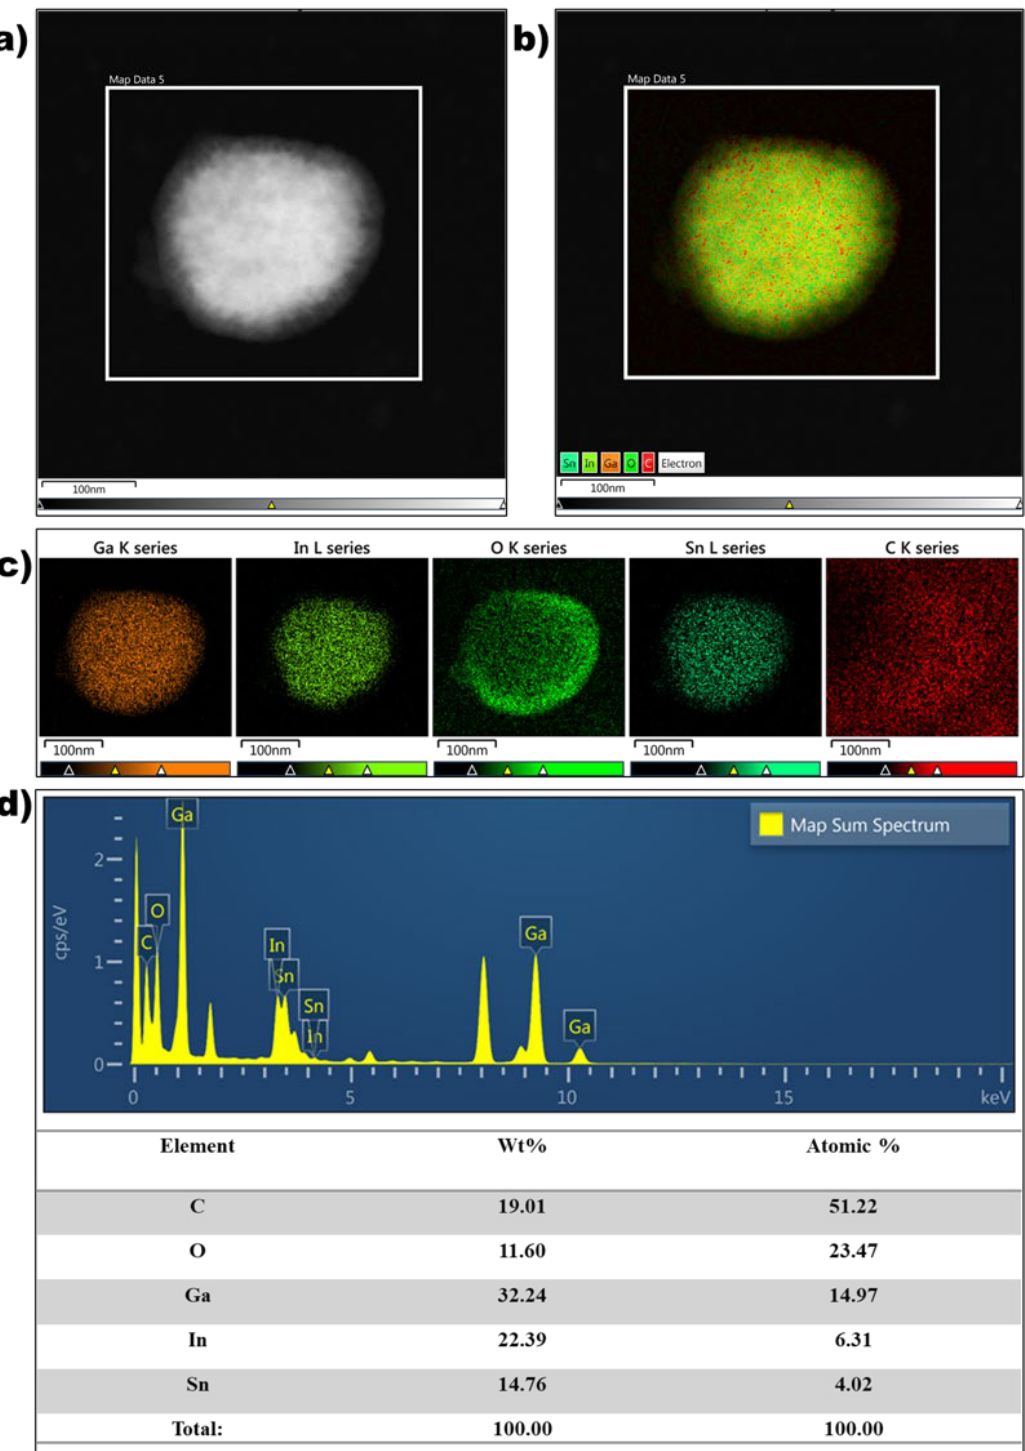
Figure 3. ( a ) TEM electron image, ( b ) STEM image, ( c ) TEM/EDS mapping, and ( d ) TEM/EDS spectra and atomic composition of a single EGaInSn LMNP.